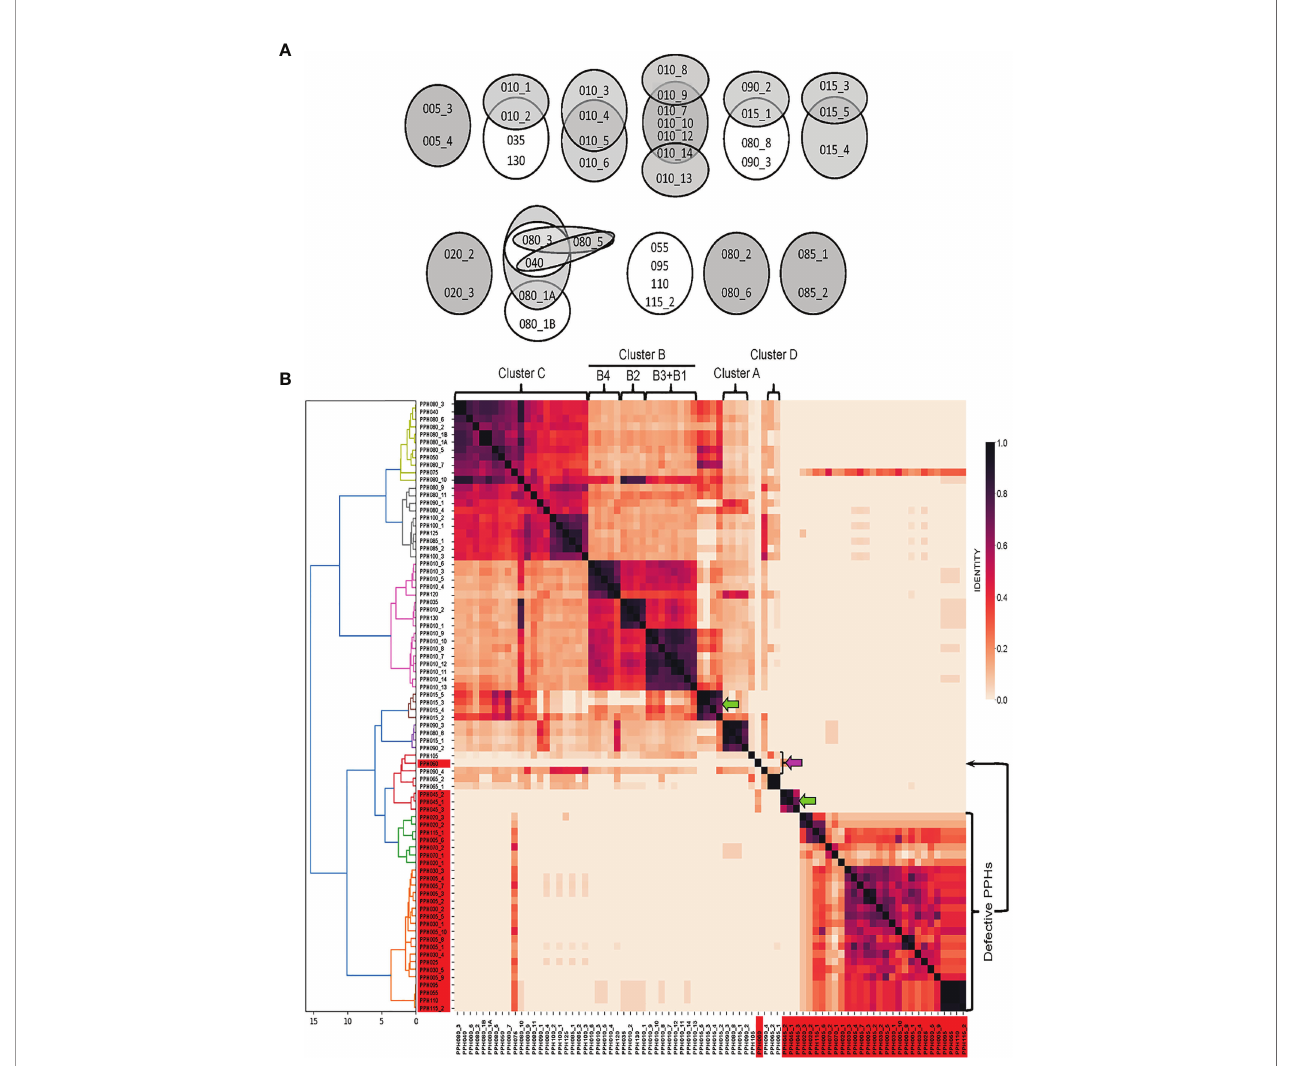
FIGURE 1 | Sequence similarities between PPHs genomes. (A) Venn diagrams showing equivalent or very similar pneumococcal prophages. Two PPH genomes were considered ‘ equivalent ’ when they overlapped for ≥ 90% of their length and showed ≥ 90% sequence identity (shown on a white background). When two genomes overlapped between 80 and 89% of their length, and nucleotide identities were ≥ 90%, the corresponding PPHs were considered as ‘ very similar ’ . They are shown on a gray background. (B) . wGRR similarity heatmap depicting the amino acid identity shared between pairs of prophage sequences (either full-length or defective prophages). Different colors were applied to clusters showing distance thresholds > 4. For agglomerative hierarchical clustering, distances are shown in the X axis. The dendrogram and heatmap python tools of the scipy.cluster.hierarchy library were used to depict fi nal agglomerative hierarchical clustering and heatmap plots, respectively. Green and pink arrows point to new clusters or singletons respectively. The correspondence between PPHs and the cluster organization of pneumococcal prophages previously reported (Brueggemann et al., 2017; Rezaei Javan et al., 2019) is indicated at the upper part of this panel. See Table S4 for a proposed correlation between previously described pneumococcal prophages and PPH